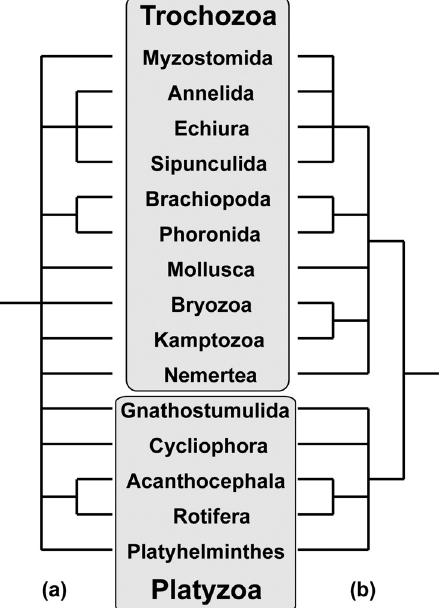
Fig. 1. – Hypotheses of lophotrochozoan relationships: a conserva- tive view (a) and an optimistic view